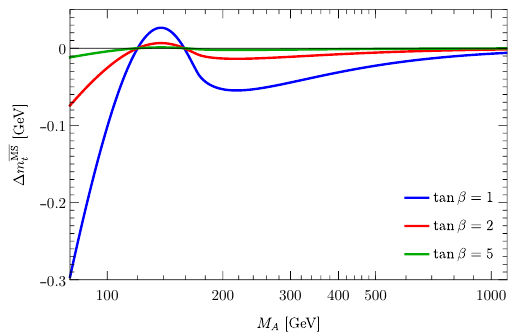
Figure 8 . Shifts to the SM MS top mass induced by non-SM Higgs bosons as a function of M A for tan (cid:12) = 1 (blue), tan (cid:12) = 2 (red) and tan (cid:12) = 5 (green).